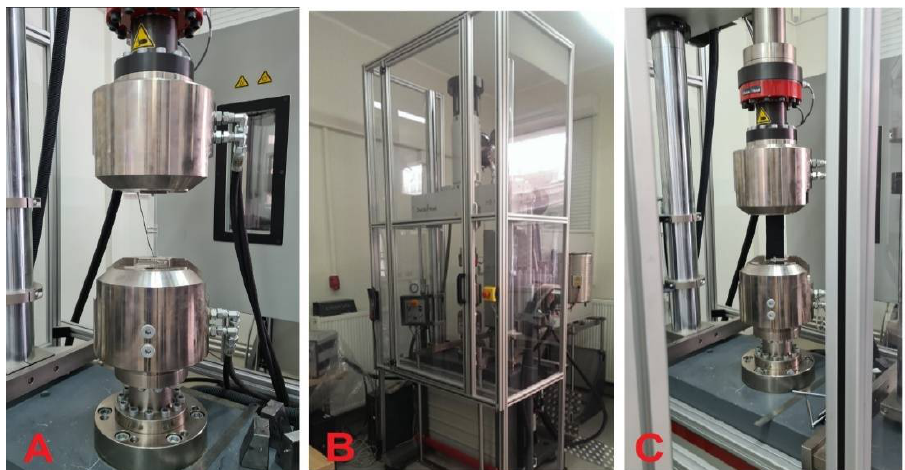
Figure 3. The stand for mechanical tests: ( A ) TPU Tensile strength test; ( B ) overall of the Zwick Roell universal testing machine for mechanical tests; ( C ) TE324 polyester belts strength test Source: Own research (2021).